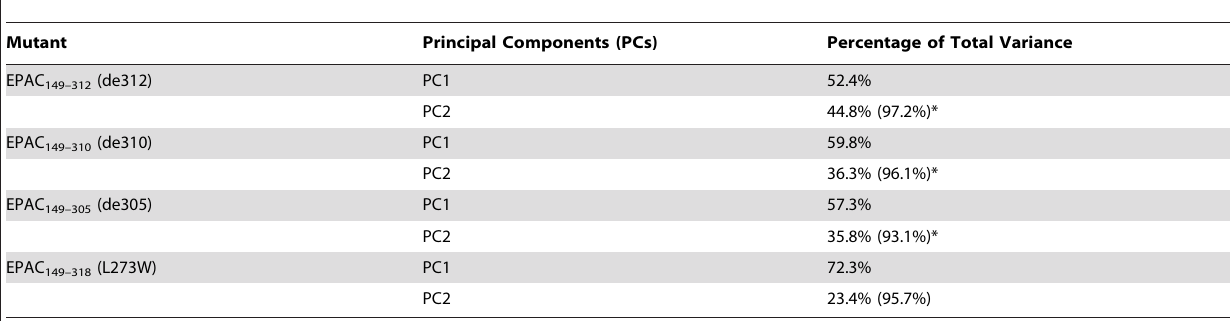
Table 1. Total Variance Breakdown in the SVD Analysis of Deletion Mutants and L273W.